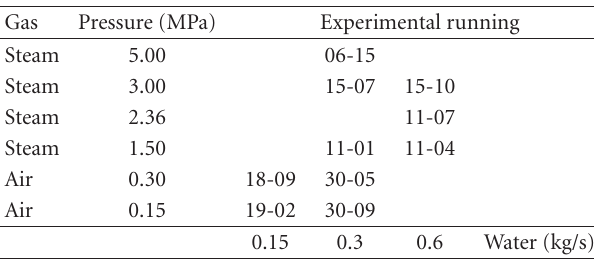
Table 1: Analyzed experimental